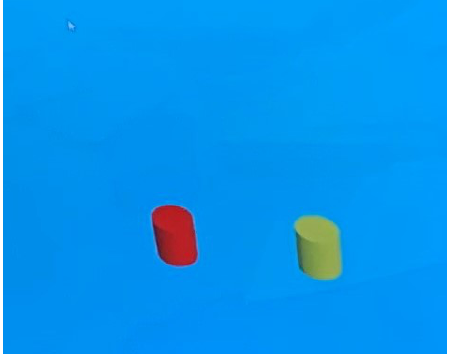
Figure 4. The participant’s view during the experiment.